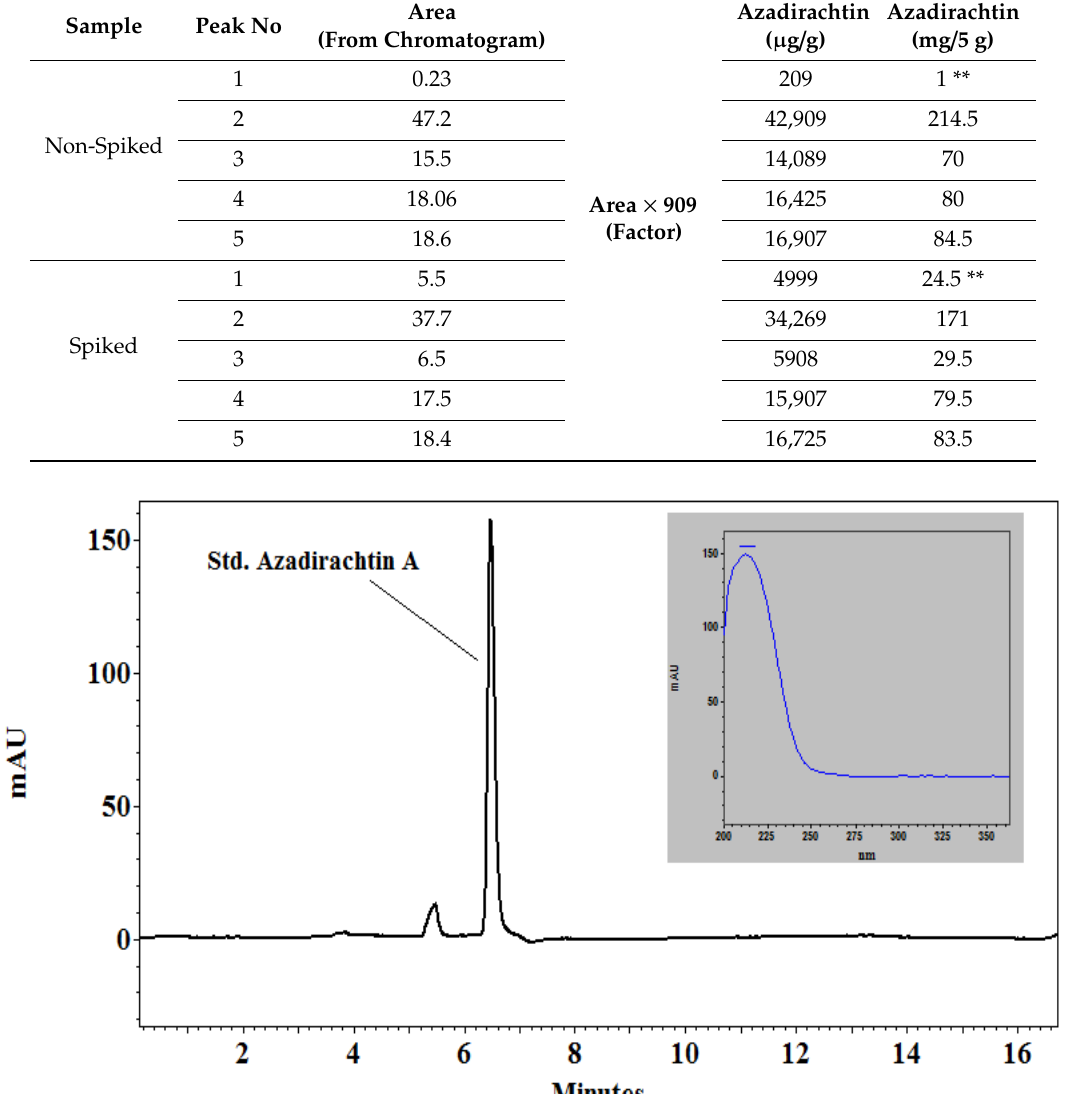
Table 1. Table representing the area of the peaks as analyzed from the chromatogram and calculating the amount of azadirachtin present in the given neem leaf extract samples. ** is the azadirachtin A concentration found in the neem leaf extracts.